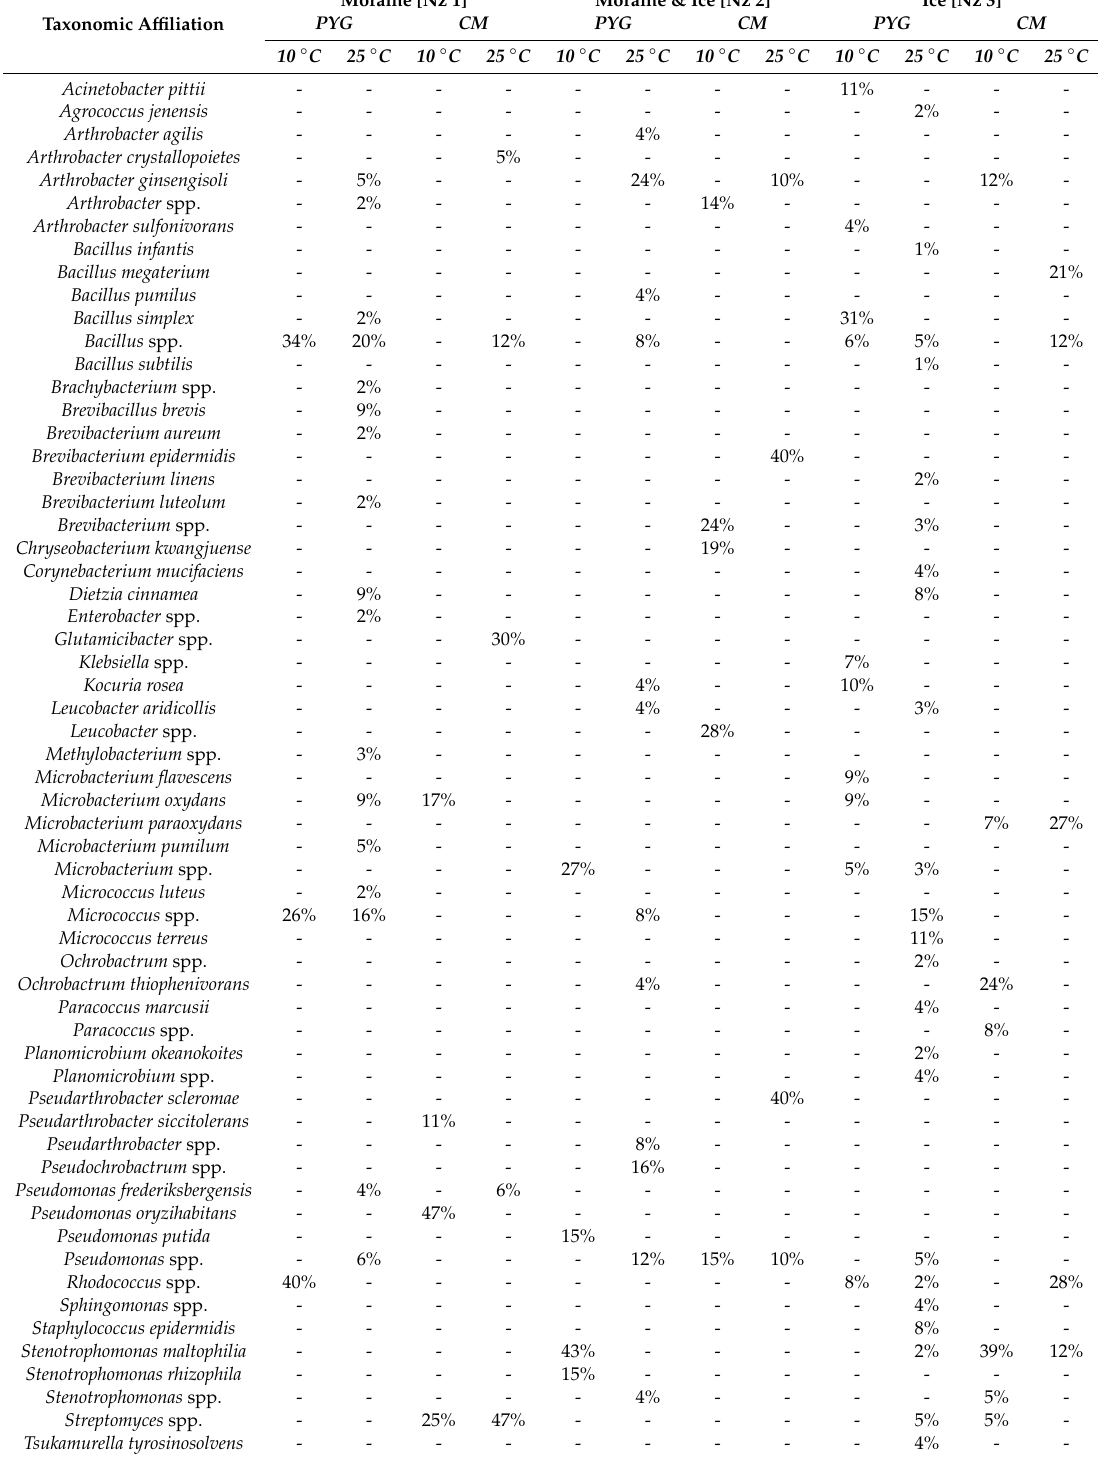
Table A2. Culturable communities’